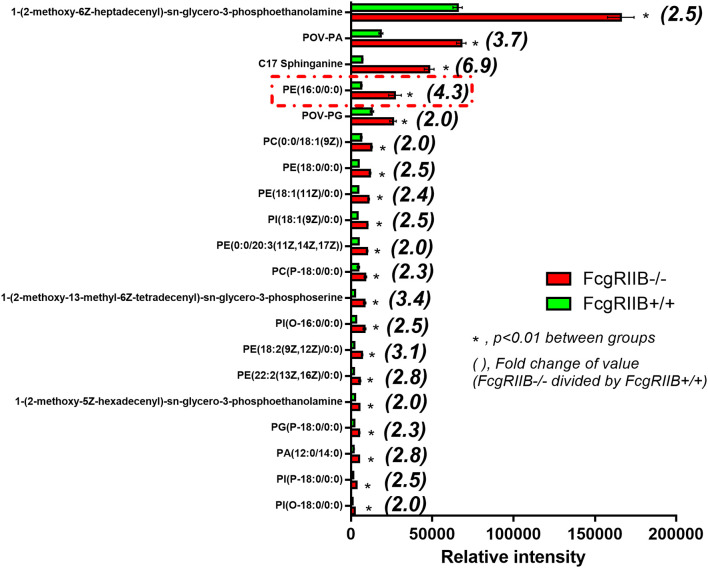
Top first 20 high intensity lipid derivatives in macrophages after LPS-tolerance (100/100) from FcgRIIB–/– vs. wild-type (FcgRIIB+/+) identified by lipids map gateway with a cut off p-value < 0.01 together with the difference of values with more than 1.5 fold-change is demonstrated (Independent triplicate experiments were performed to prepare cells for lipidomic analysis).